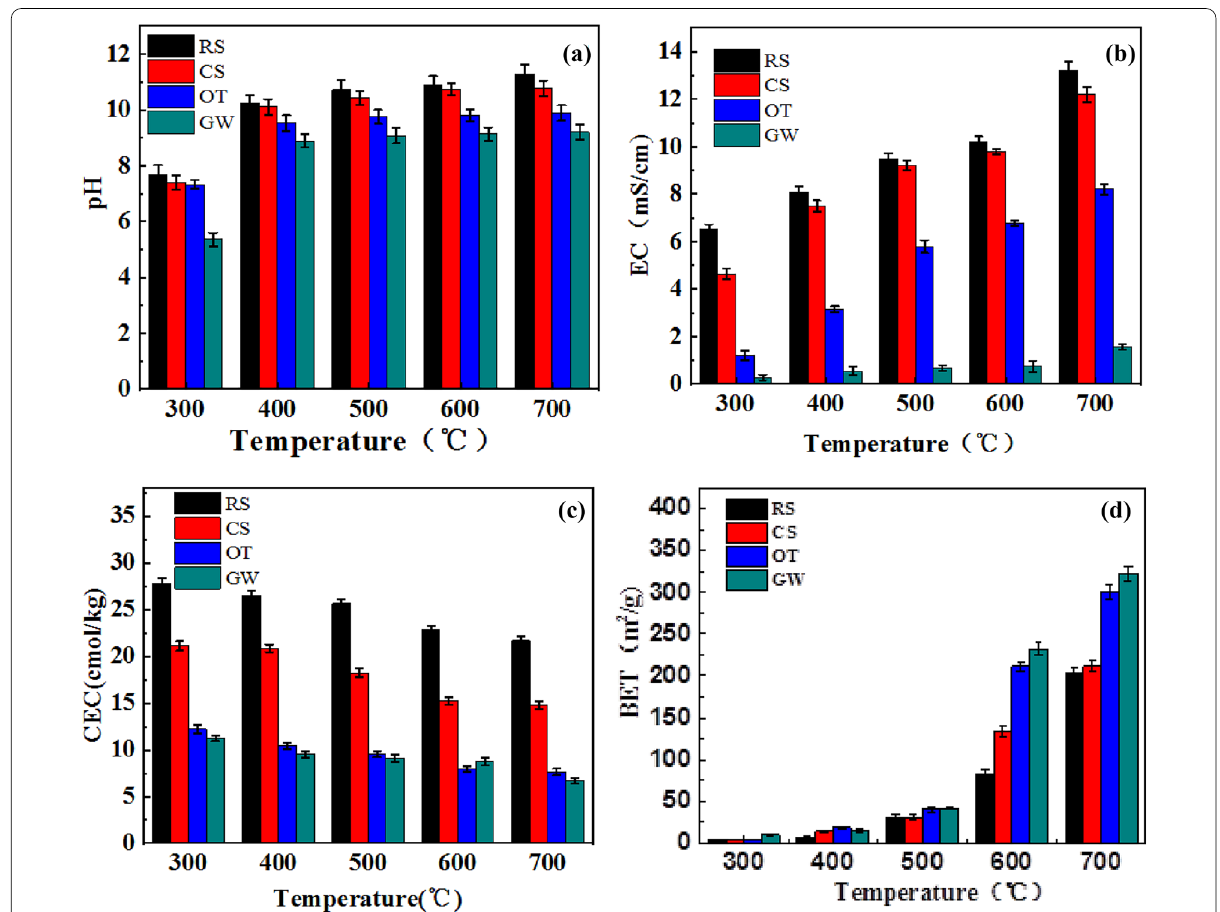
Fig. 3 a pH, b EC value, c CEC, d BET